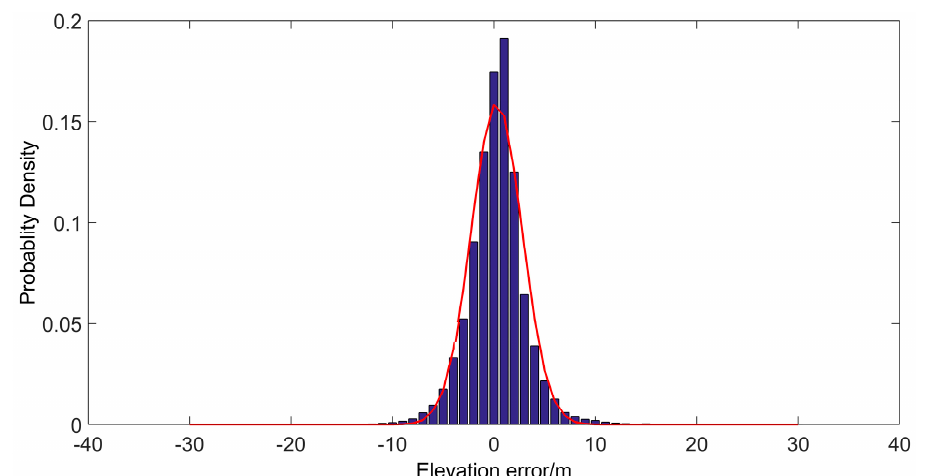
Figure 11. DEM by LiDAR and GB-InSAR.